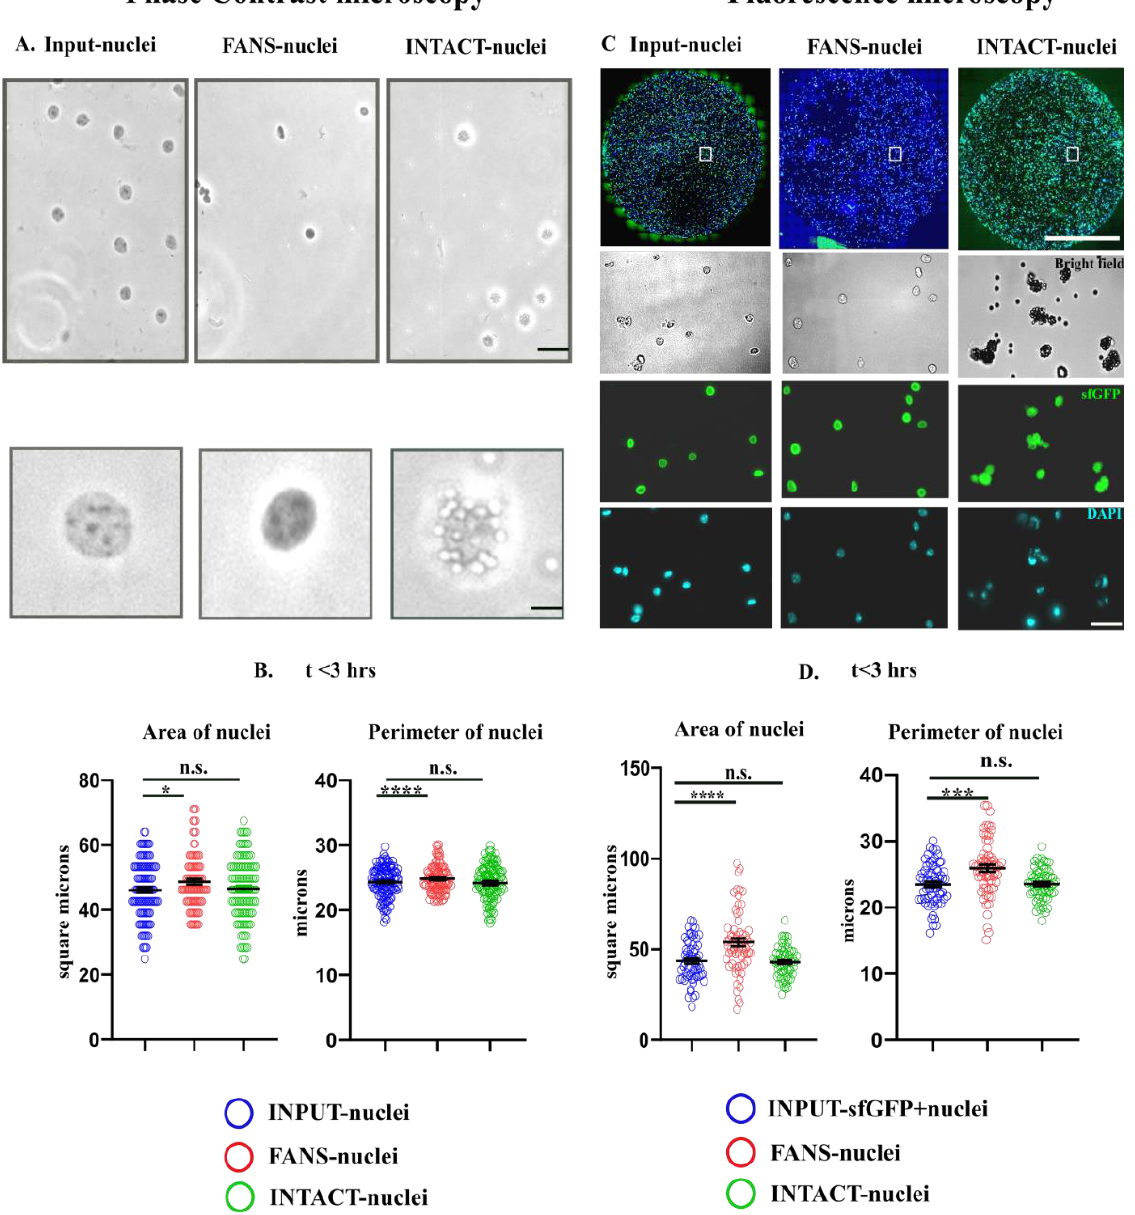
Figure 3. Morphological comparisons between FANS- and INTACT-sorted nuclei. Nuclei were isolated from the neocortices of 13–16 week old mice and sfGFP+ nuclei were sorted using FANS or INTACT. ( A ) For phase contrast microscopy, sorted nuclei were observed within 2–3 h of the sort. Representative images of INPUT-, FANS- and INTACT-nuclei. Scalebar: 25 µ m. ( B ) Nuclei area and perimeter after sorting with FANS or INTACT. Both parameters in FANS- but not INTACT nuclei (n.s. ( p > 0.05) increased significantly compared to the INPUT-nuclei ( p < 0.05 (*), n = 100–200 nuclei). Scalebar: 5 µ m, Air Objective, 40 × . ( C ) For fluorescence microscopy, sorted nuclei were embedded in IBIDI chambers within 3 h or within 4–6 h of the sort. Representative images of INPUT-, FANS- and INTACT-nuclei (within 3 h of the sort) in the wells of IBIDI chambers and the representative enlarged images showing brightfield, GFP, and DAPI fluorescence along with the magnetic beads (2.8 µ m diameter) showing a green autofluorescence (for INTACT) are shown. Scale bar: 2 mm (inset), scale bar—25 µ m, water objective, 20 × and 40 × . ( D ) Analysis of nuclei area embedded in the IBIDI chambers within 3 h after sorting manually. Significant increase in the size of FANS-nuclei <3 h of sorting (nuclei area and perimeter) compared to the sfGFP+ INPUT-nuclei ( p < 0.001 (***), p < 0.0001 (****), n = 100–200 nuclei) while no significant changes in INTACT-nuclei.